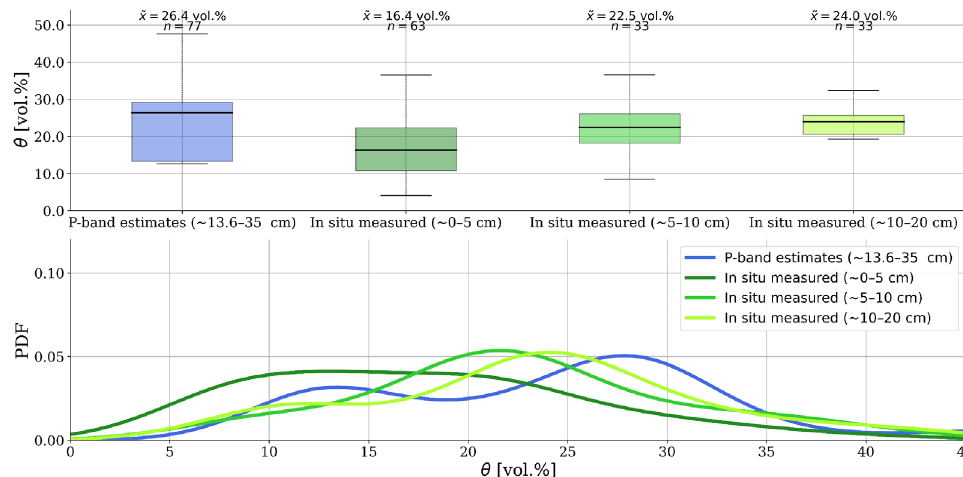
Figure 12. Comparison of retrieved soil moisture values, estimated with the proposed P-band SAR method and converted from permittivity according to the dielectric mixing model from [71], with in situ measured soil moisture values from various networks (cf. Section 2) at the AirMOSS monitoring site MOISST, OK. (cid:101) x represents the respective median value, n is the total amount of values per boxplot.